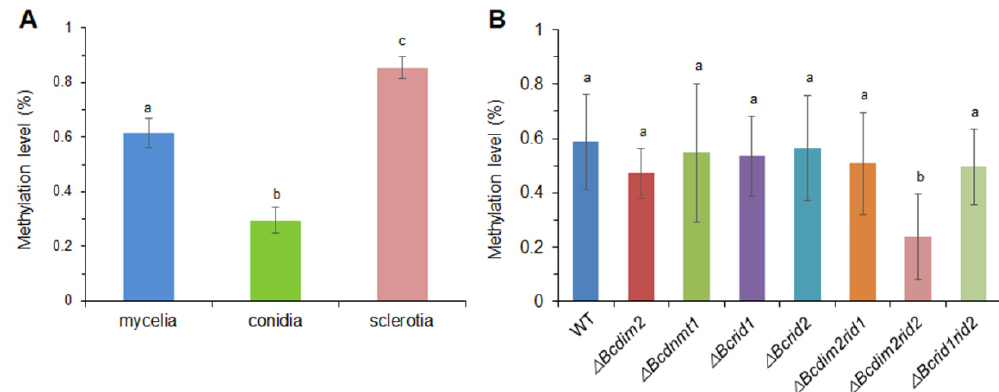
Figure 9. The methylation levels in different tissues and different strains of B. cinerea . ( A ) The global methylation levels in different tissues of B. cinerea . ( B ) The global methylation levels in wild-type and mutants. A total of 100 ng DNA of each strain was added and fixed on a strip well with a specific affinity for DNA. DNA methylation level was quantified by a 5mC capture antibody and a detection antibody. The amount of methylated DNA was proportional to the optical density (OD) values obtained from the enzyme-linked immunosorbent assays and is presented according to the calculated percentage of 5mC. Columns with different letters indicate significant differences ( p < 0.05).